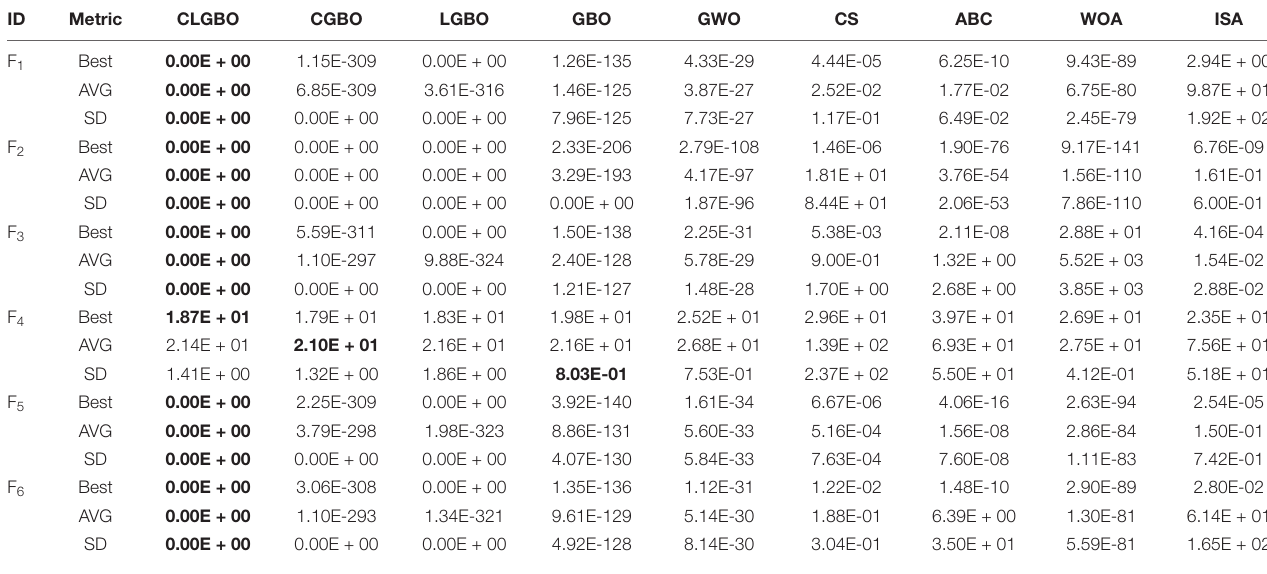
TABLE 2 | Results of the unimodal test